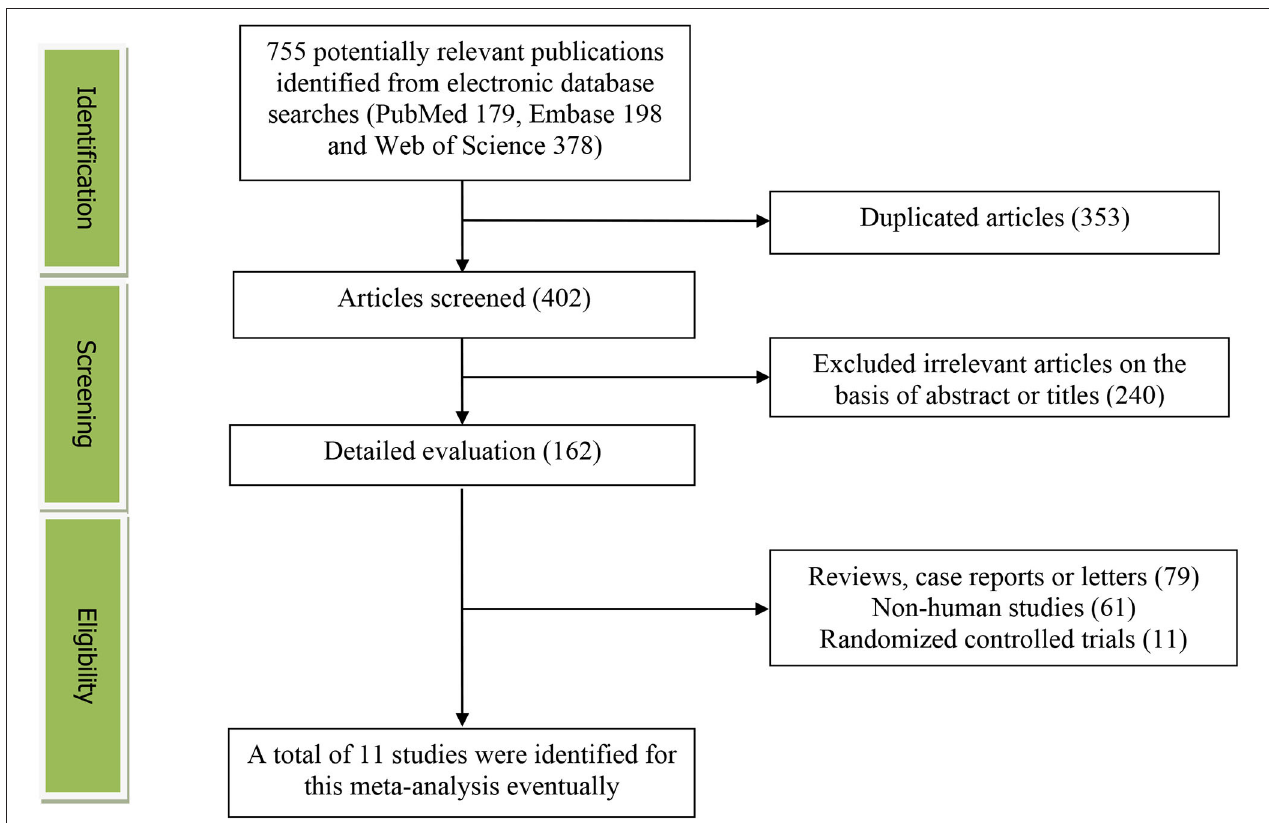
FIGURE 1 | The detailed flow diagram of the study identification and selection in this